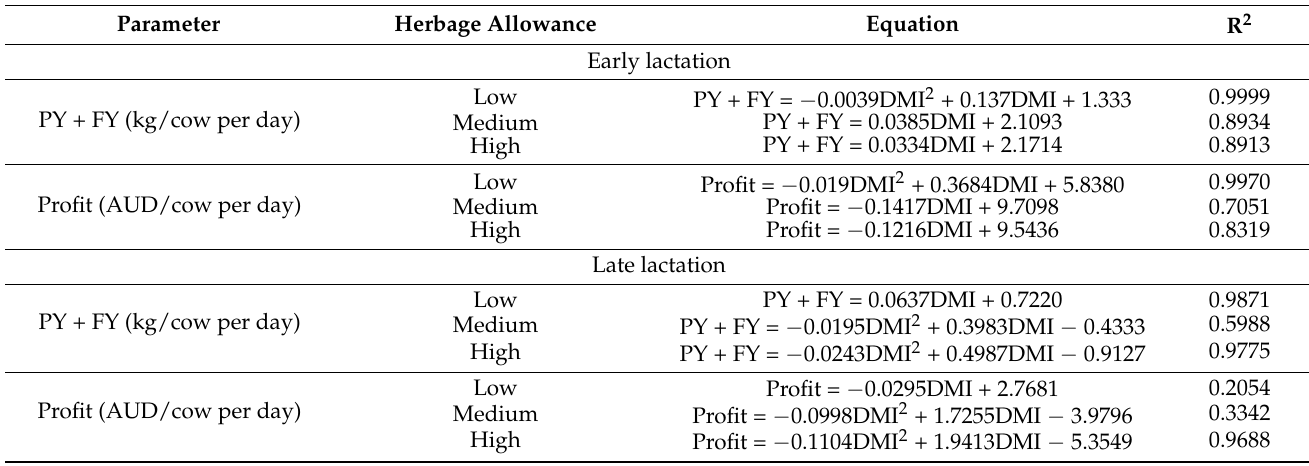
Figure 1. ( a ) Milk protein plus fat production and ( b ) profit (total milk income minus feed cost in AUD) with changing partial mixed ration intake in early lactation where herbage allowance was low ( (cid:4) ), medium ( fitted relationships for low (line with short dashes), medium (solid line) and high (dot-dash line) herbage allowance. Vertical bracket represents least significant difference ( p = 0.05). Table 2. Equations describing the relationships between partial mixed ration (PMR) dry matter intake (DMI; kg DM/cow per day) and milk protein plus fat yield (PY + FY) and profit (total milk income minus feed costs) for cows offered low, medium and high herbage allowance 1